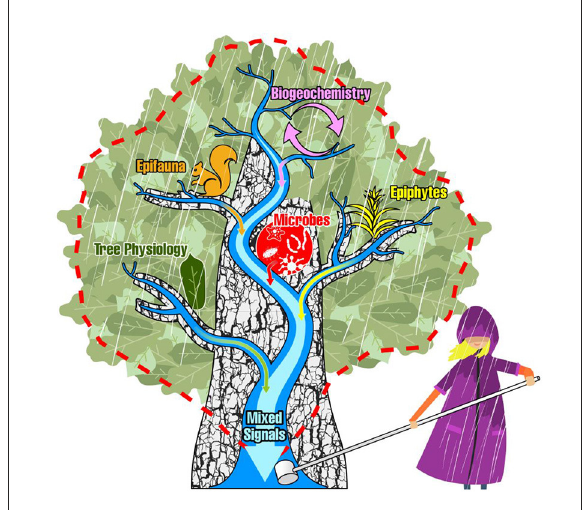
FIGURE1 The classical depiction of a dendritic stream network and its watershed boundary (blue streams and red dashed line) is projected over the dendritic branchflow network of a tree canopy to illustrate the conceptual overlap. Here, stemflow at the base of the tree is analogous to the watershed discharge point. Signals are imparted to draining rainwaters from biogeochemical processes, epifauna, epiphytes, microbial communities, and the physiological processes of the tree itself—of which may all be sampled at a single discharge point, in